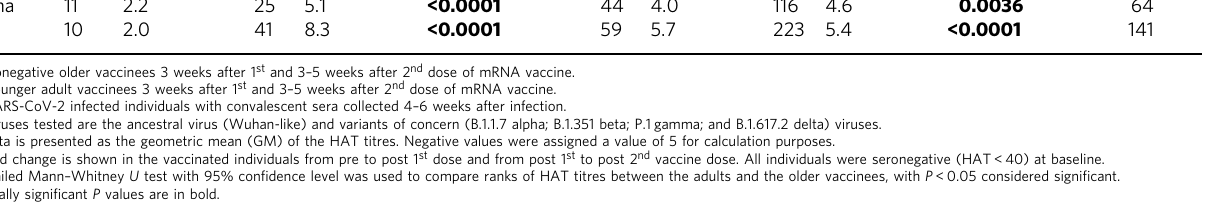
responses in younger adults to VOCs than in older vaccinees.